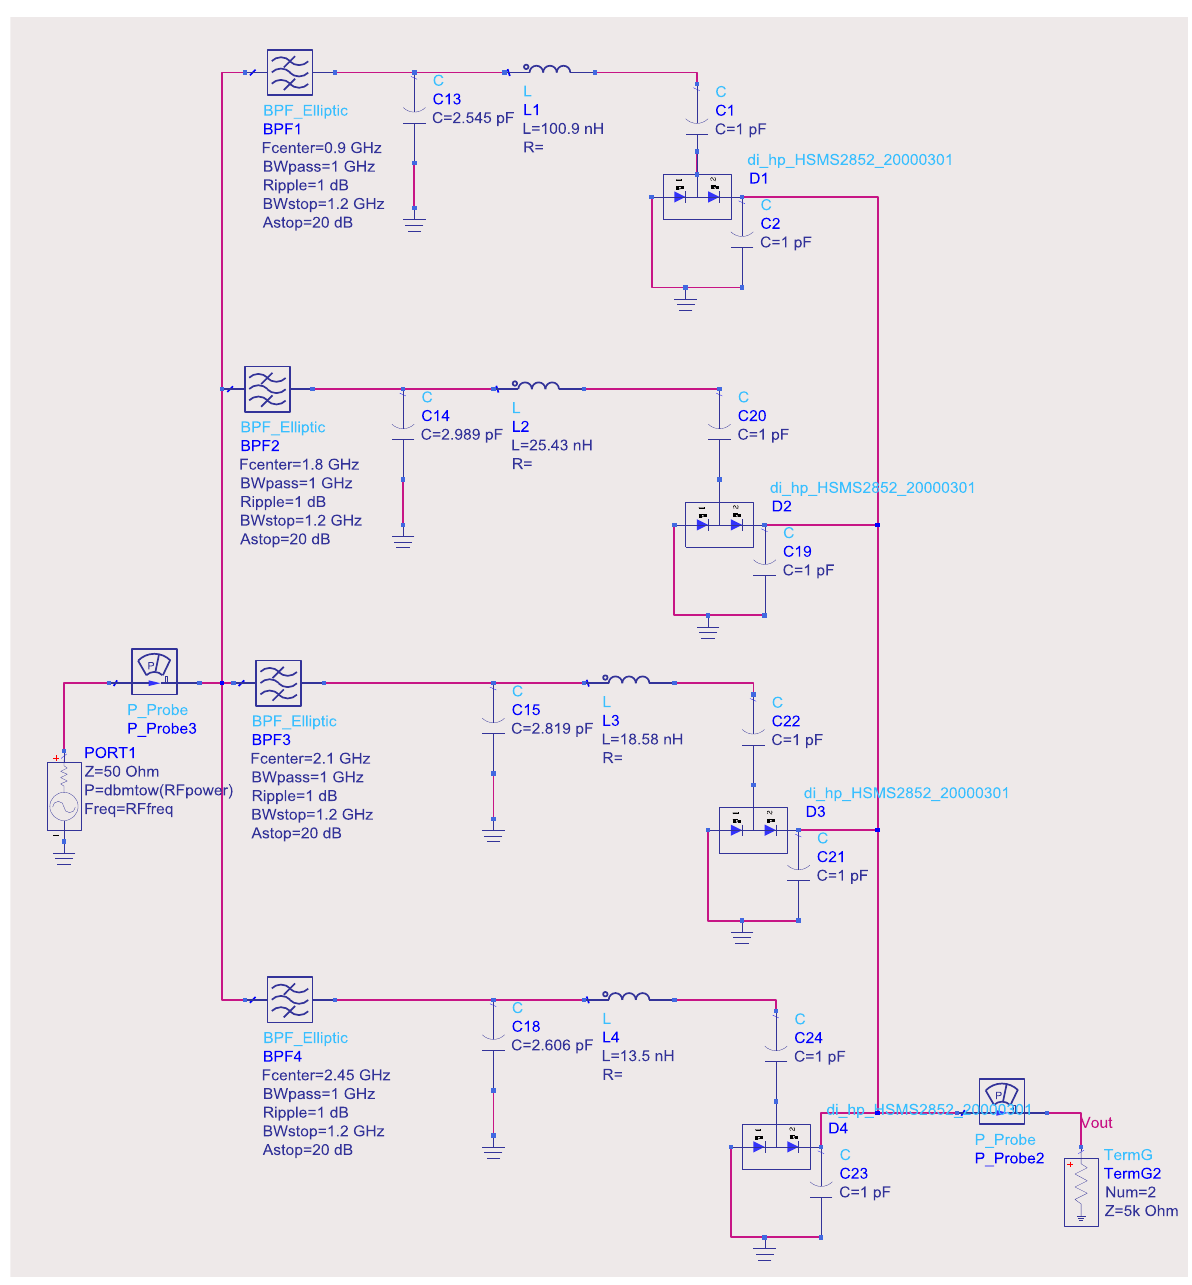
Figure 6. The proposed quad-band circuit with a single receiving